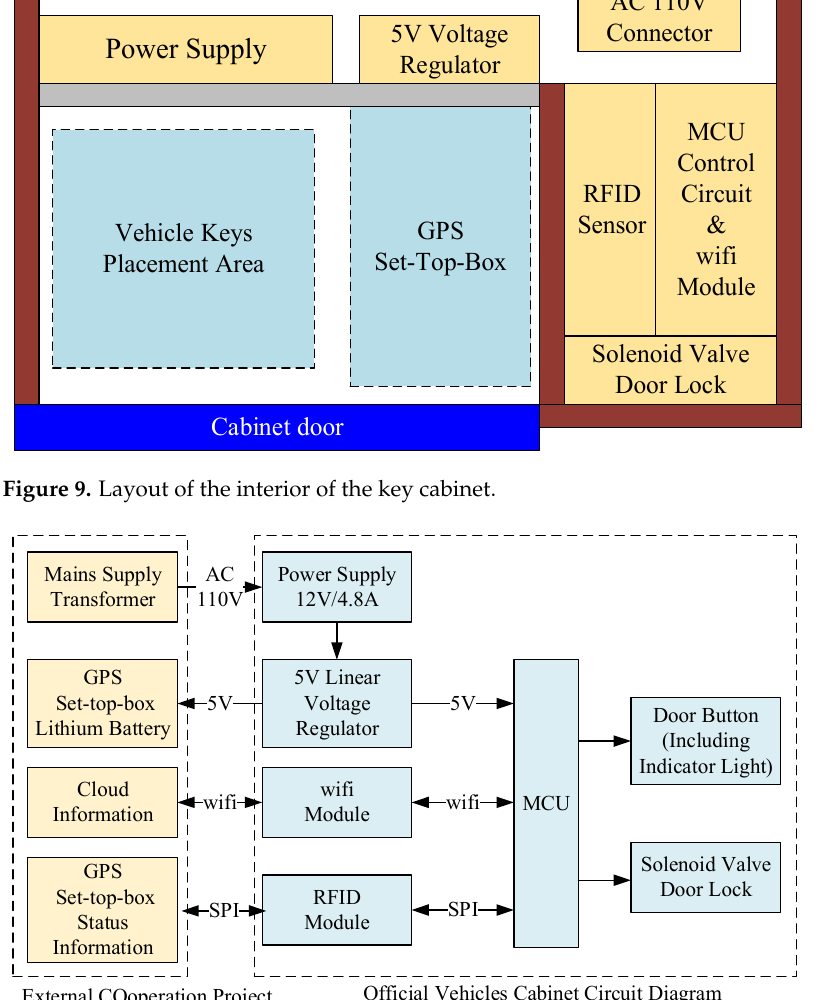
Figure 9. Layout of the interior of the key cabinet.